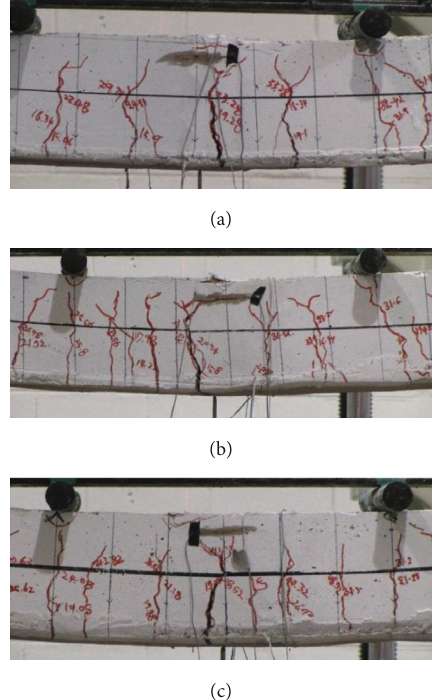
Figure 5: Crack pattern at midspan. (a) R55-B1. (b) R55-B2. (c)